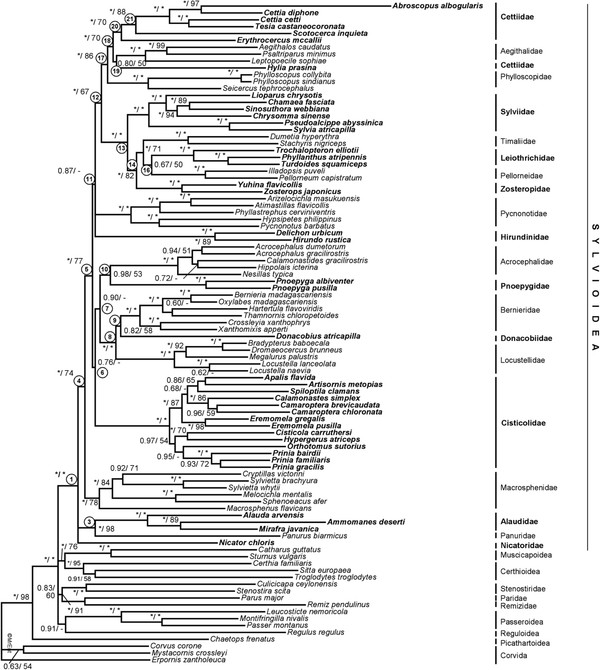
Phylogeny of Sylvioidea based on the complete data set. Phylogenetic tree based on the complete concatenated dataset (MT-CYB, FGB, GAPDH, LDHB, MB, ODC1, RAG1), analysed by Bayesian inference (partitioned by locus). Support values are given in the order posterior probability (PP) / maximum likelihood (ML) bootstrap; * indicates PP 1.00 or ML 100%; - indicates no ML bootstrap support for this node, but clade recovered in ML search for best topology. For better clarity, families belonging to Sylvioidea are alternately written in bold. Node numbers are the same as in Figure 2.